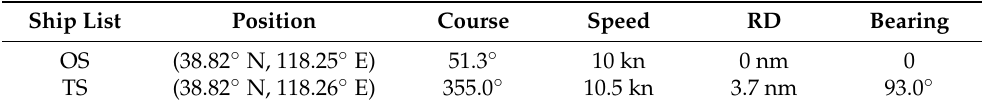
Table 5. Initial information (crossing).